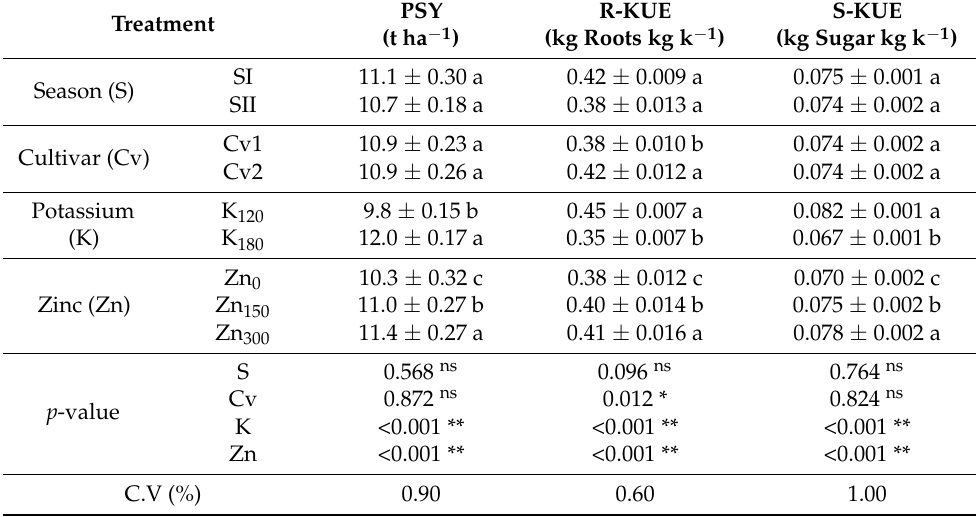
Table 7. Pure sugar yield (PSY), potassium use efficiency (based on root yield (R-KUE), and pure sugar yield (S-KUE)) of two sugar beet cultivars (e.g., Kawemira (Cv1) and BTS 301 (Cv2)) affected by soil fertilization with two potassium levels (e.g., 120 (K 120 ) and 180 kg ha − 1 (K 180 )) and foliar application with three zinc levels (e.g., 0 (Zn 0 ), 150 (Zn 150 ), and 300 ppm (Zn 300 )) when grown